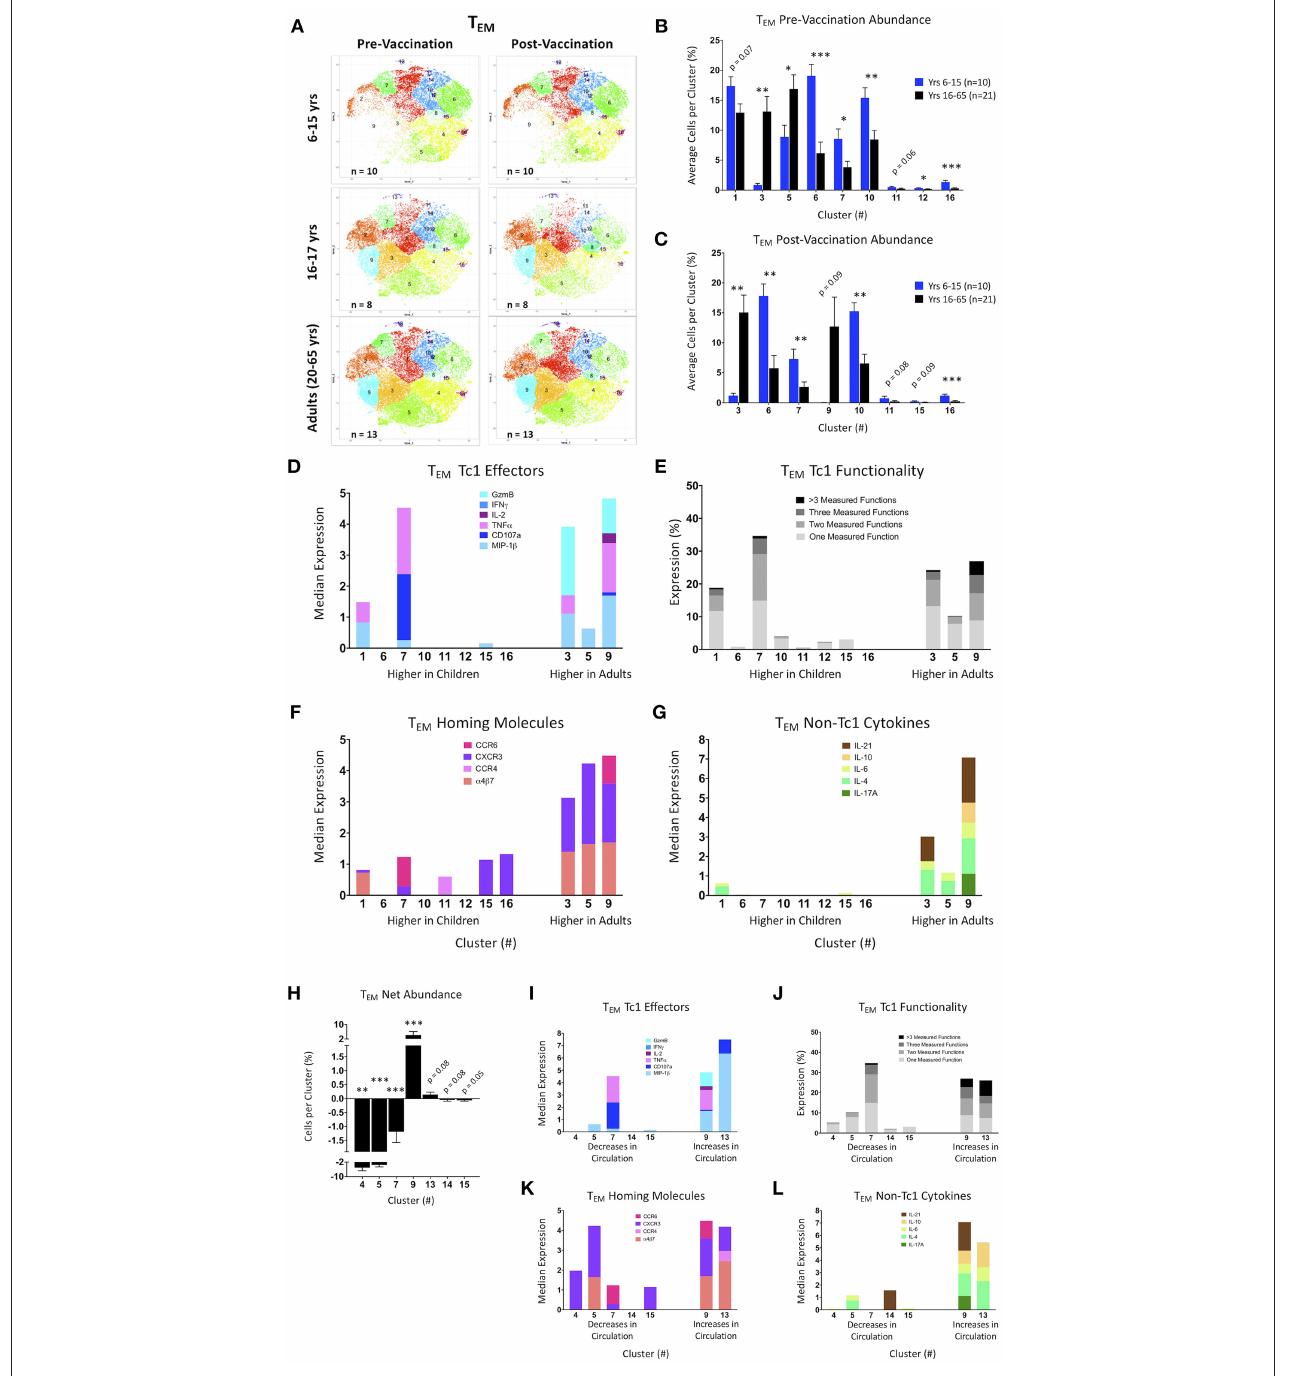
FIGURE 5 | tSNE analysis of activated CD8 + T effector memory populations. (A) tSNE maps of pre- and post-Ty21a vaccinated 6–15 year old, 16–17 year old, and adult participants. (B,C) Significantly different clusters between age groups (6–15 year old and 16 years and over) represented by bar graphs identifying the average percent of cells per volunteer per cluster in pre-Ty21a (B) and postTy21a (C) immunization timepoints. (D–G) Functions of significantly different tSNE clusters from (B,C) , divided into: (D) median expression of Tc1 effector functions MIP1 β , CD107a, TNF α , IL-2, IFN γ , and Granzyme B (GzmB). (E) Winlist FCOM-analysis determined Tc1 mono- and multifunctional cytokine expression. (F) median expression of homing markers, and (G) median expression of non-Tc1 associated cytokines. (H) Clusters showing significant net changes in the percent of cells following Ty21a vaccination. (I–L) Functions of significantly different tSNE clusters from (H) , divided into: (I) . median expression of Tc1 effector functions . MIP1 β , CD107a, TNF α , IL-2, IFN γ , and Granzyme B (GzmB), (J) Winlist FCOM-analysis determined Tc1 mono- and multifunctional cytokine expression, (K) median expression of homing markers, and (L) median expression of non-Tc1 associated cytokines.